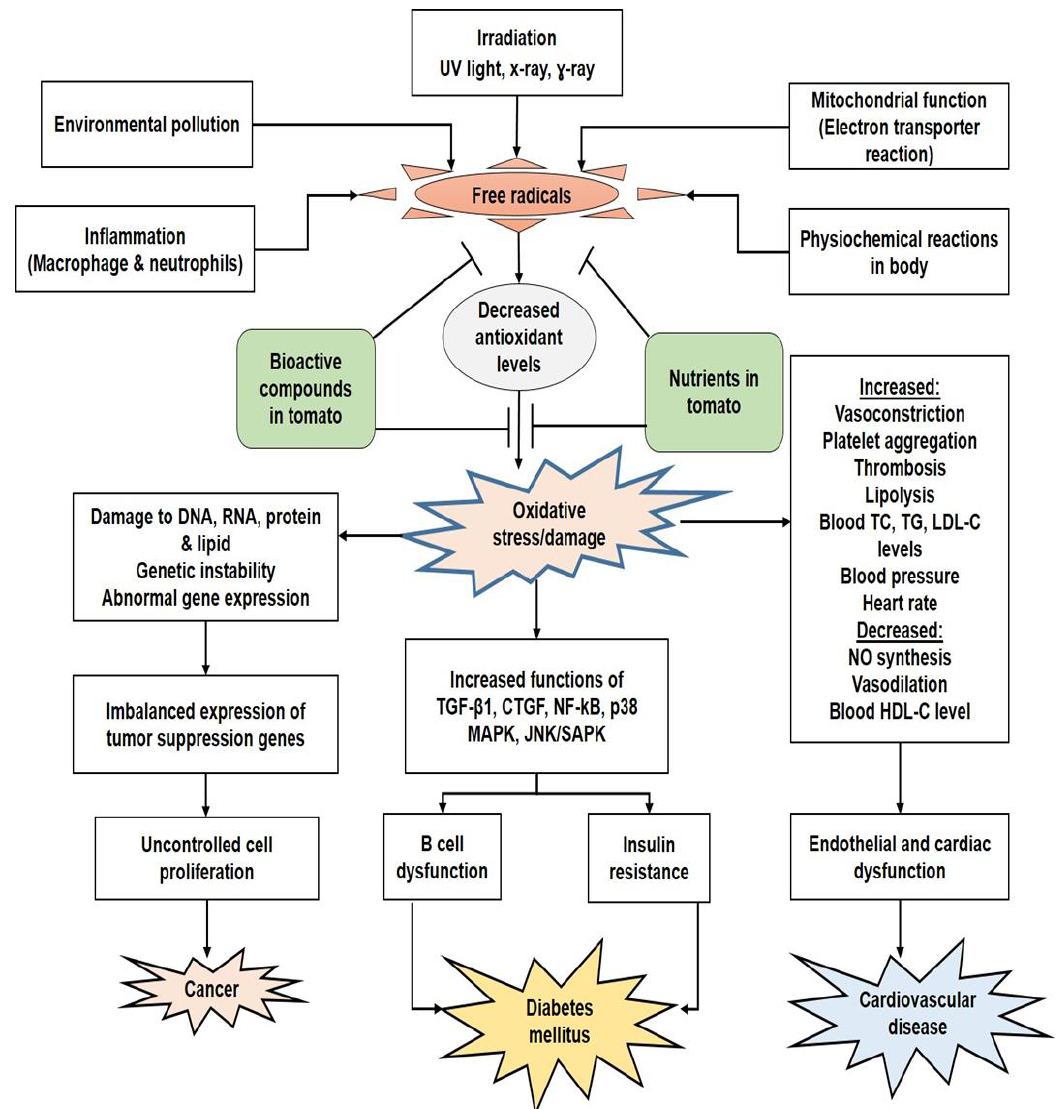
Figure 2. Summary of the effects of nutrients and bioactive compounds in tomato on cancer, diabetes mellitus and cardiovascular disease (CVD). UV: ultraviolet; DNA: deoxyribonucleic acid; RNA: ribonucleic acid; TGF-β1: transforming growth factor beta 1; CTGF: connective tissue growth factor; NF-kB: nuclear factor kappa-light-chain enhancer of activated B cells; p38 MAPK: p38 mitogen-activated protein kinase; JNK/SAPK: c-Jun N-terminal kinases/stress-activated protein kinases; TC: total cholesterol; TG: triglyceride; LDL-C: low-density lipoprotein cholesterol; NO: nitric oxide; HDL-C: high- density lipoprotein cholesterol.